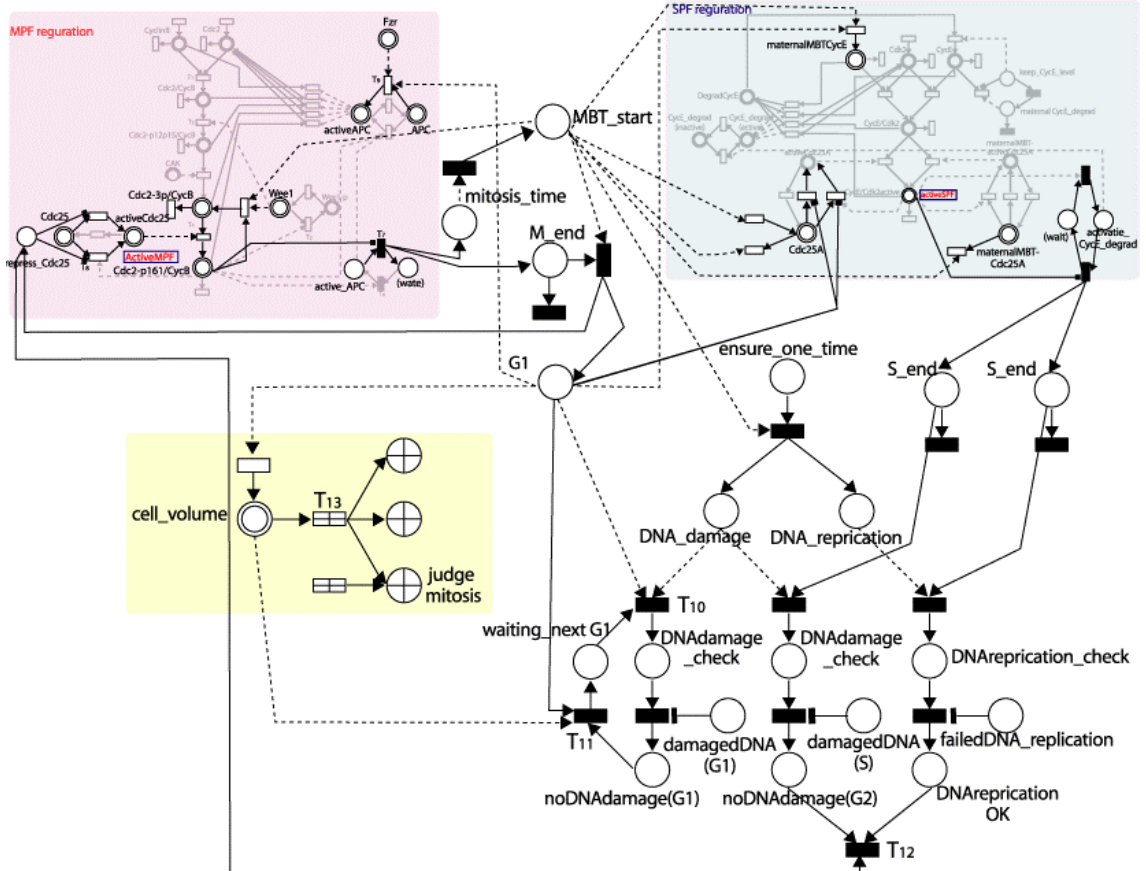
Figure 3. Mechanisms for cell division control and checkpoint sequences. The rectangular parts of pink and light blue colors correspond to Figures 1 and 2. The small circuit on the yellow rectangular is a mechanism to determine the timing of cell division. More specifically, each time the transition T13 fires, a cell divides. The elements in the circuit are special elements called "generic place and generic transition" and the functions of them have not been presented yet since concepts of these elements are quite new. The details for this circuit including the usage of these elements are described in the URL http://genome.ib.sci.yamaguchi-u.ac.jp/˜f